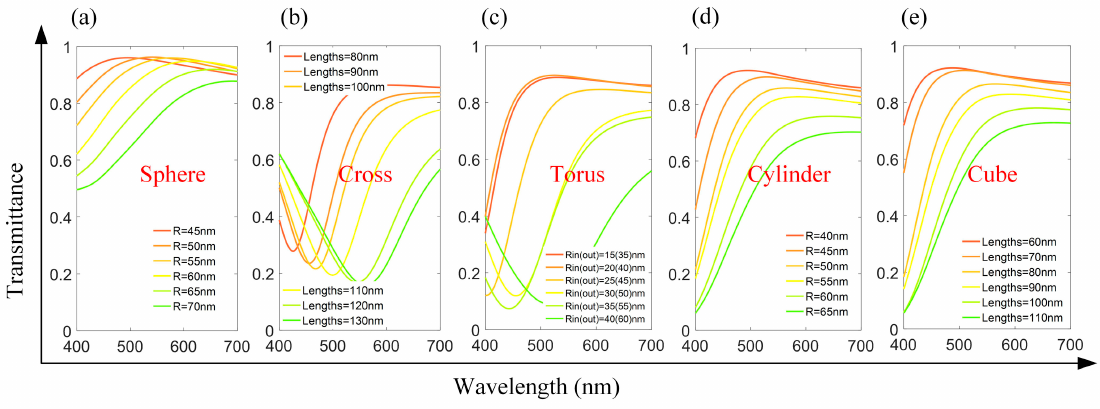
Figure 3. Transmittances of the isolated nanoparticles. ( a ) Sphere; ( b ) Cross; ( c ) Torus; ( d ) Cylinder; ( e ) Cube. In these cases, we only removed the aluminum film and kept the other parameters unchanged.